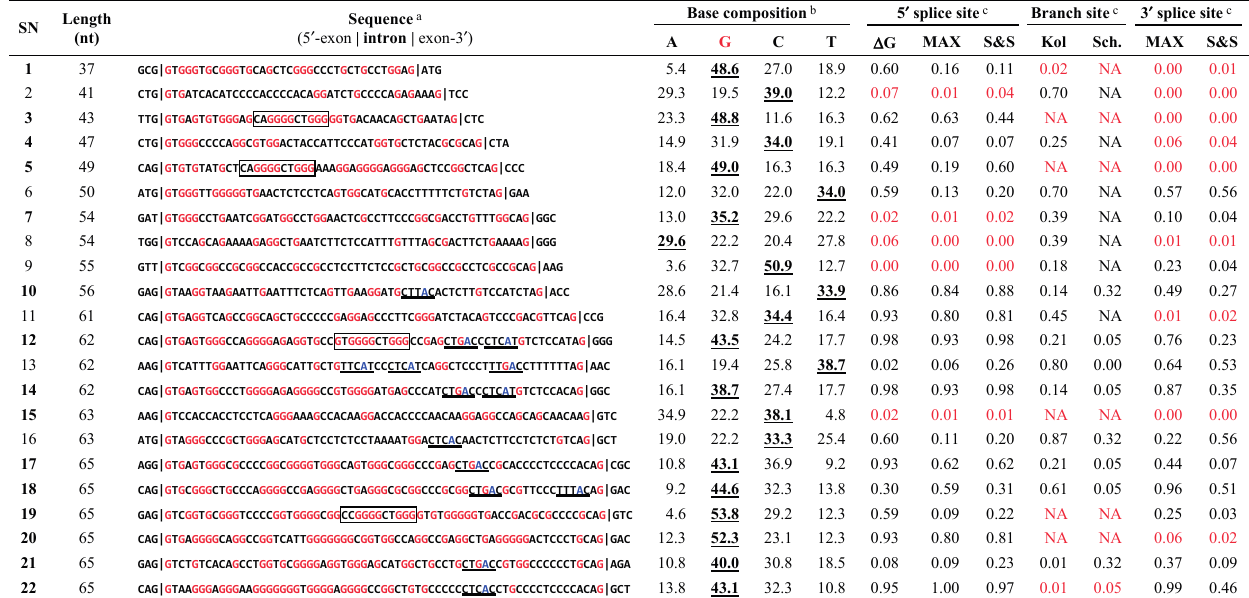
Table 2. Sequence analyses and scoring of essential splicing signals of selected ultra-short introns. a SN Length (nt) Sequence (5 ′ -exon | intron | exon-3 ′